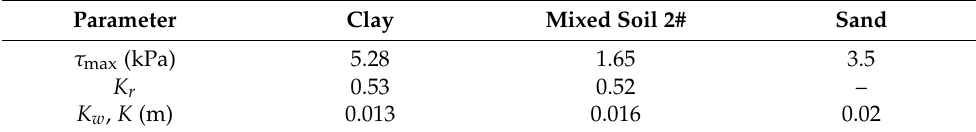
Figure 19. Curve fitting of clay, sand and mixed soil 2#. Table 6. Parameters of the shear stress–displacement model.